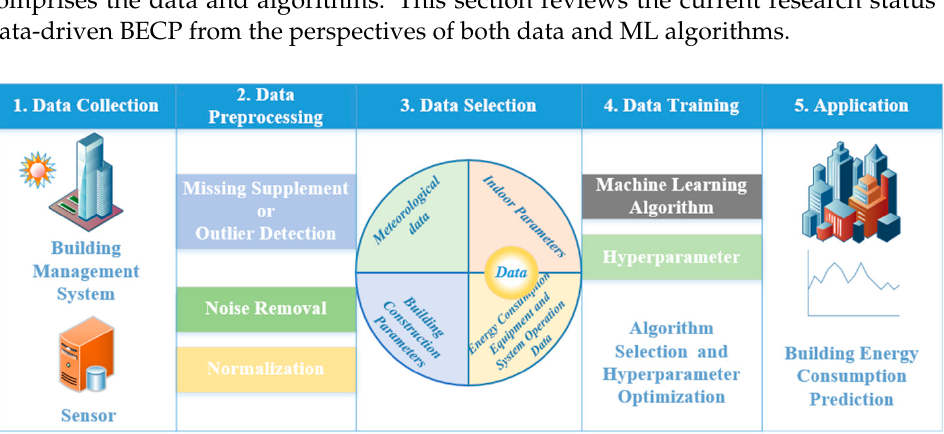
Figure 2. Data-driven method process in BECP.